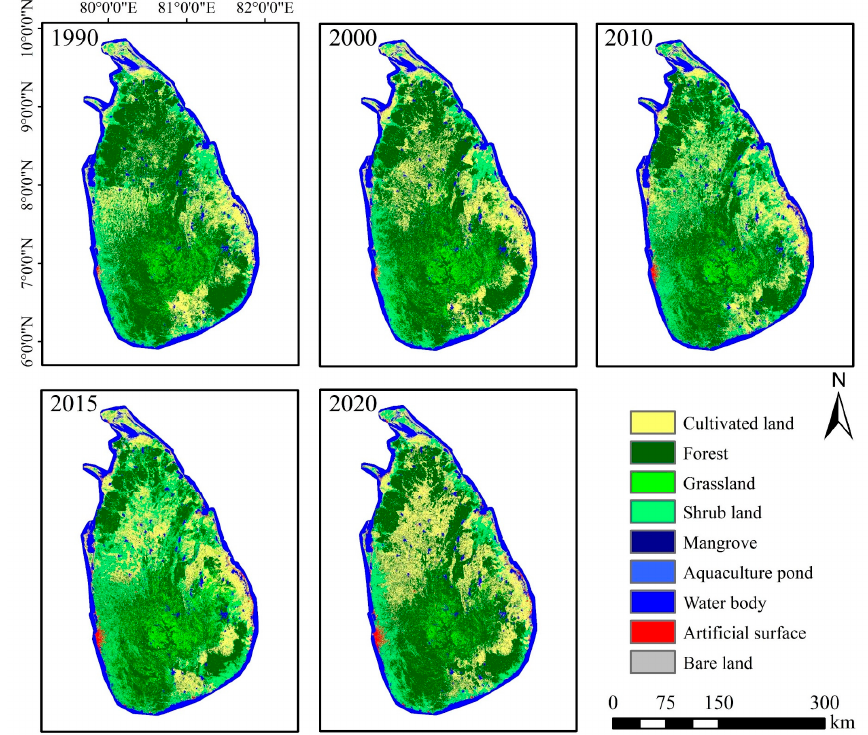
Figure 2. Spatial distribution of land cover in Sri Lanka from 1990 to 2020.